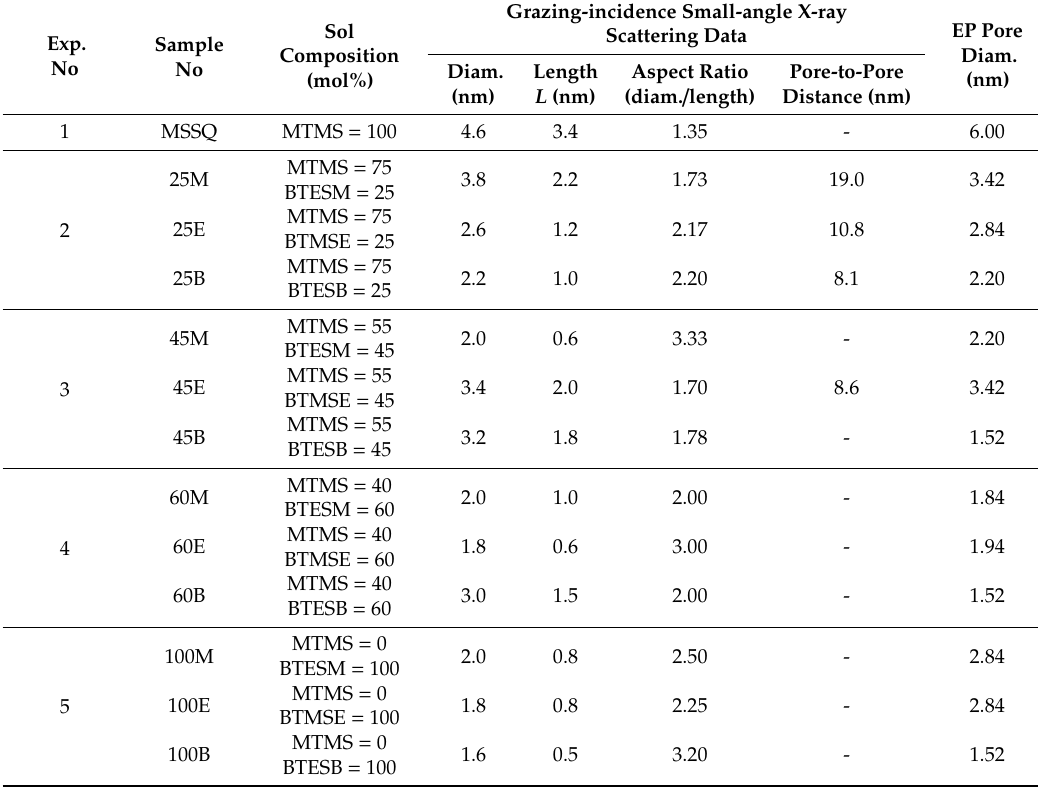
Pore geometry (cylinder disc pore diameter, length, aspect ratio) and pore-to-pore distance of porous methylsilsesquioxane film (MSSQ) and organosilicate glass films